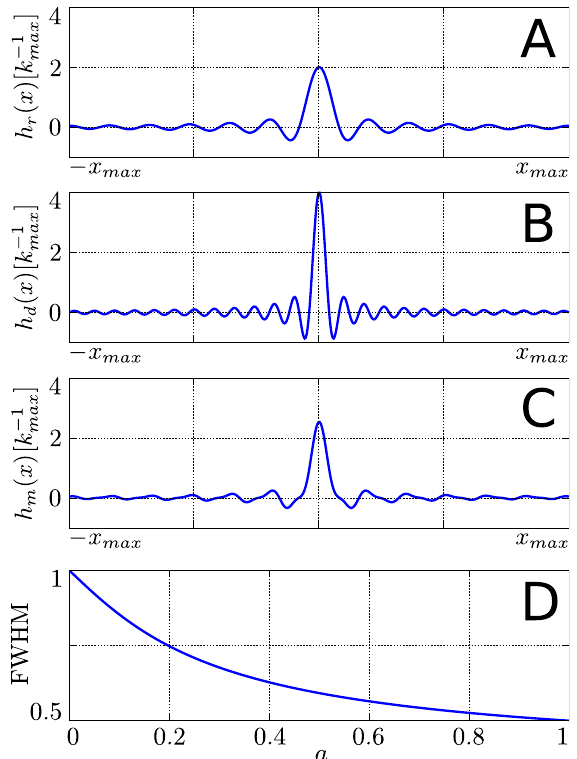
Figure 4. Graphical display of ( A ) the regularly sampled PSF, h Equation (5); ( B ) the doubly-sampled PSF, h ( x ) , as shown in Equation (17) with values of T PSF, h m a = e − 1 ; ( D ) The dependence of the normalized (with respect to h as a function of real values of a (Equation